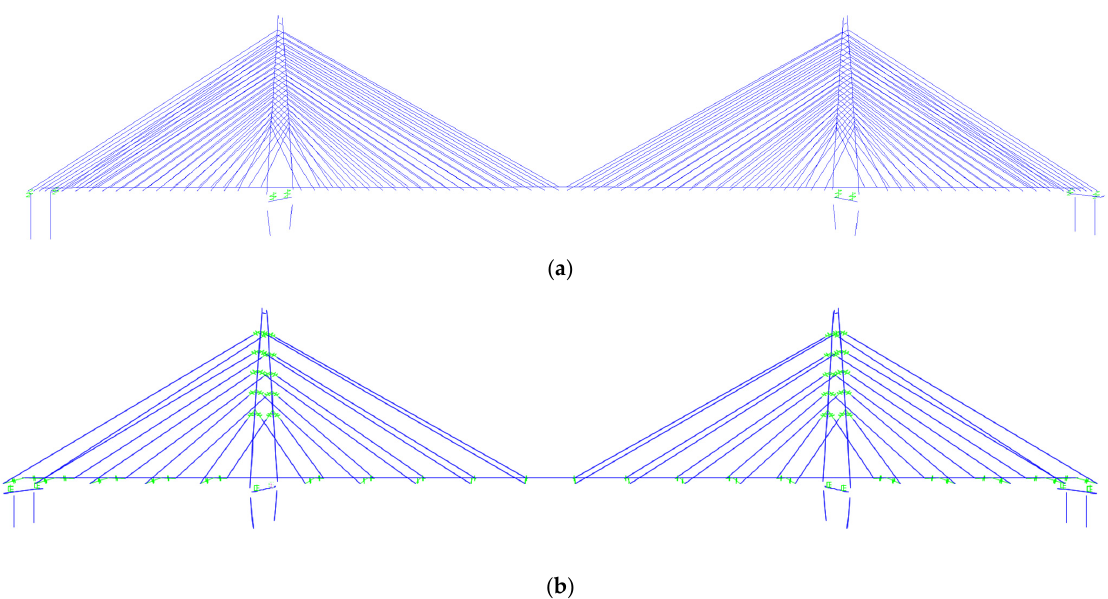
Figure 13. Finite element model: ( a ) prototype bridge; ( b ) test model. Table 3. Comparison of natural periods.